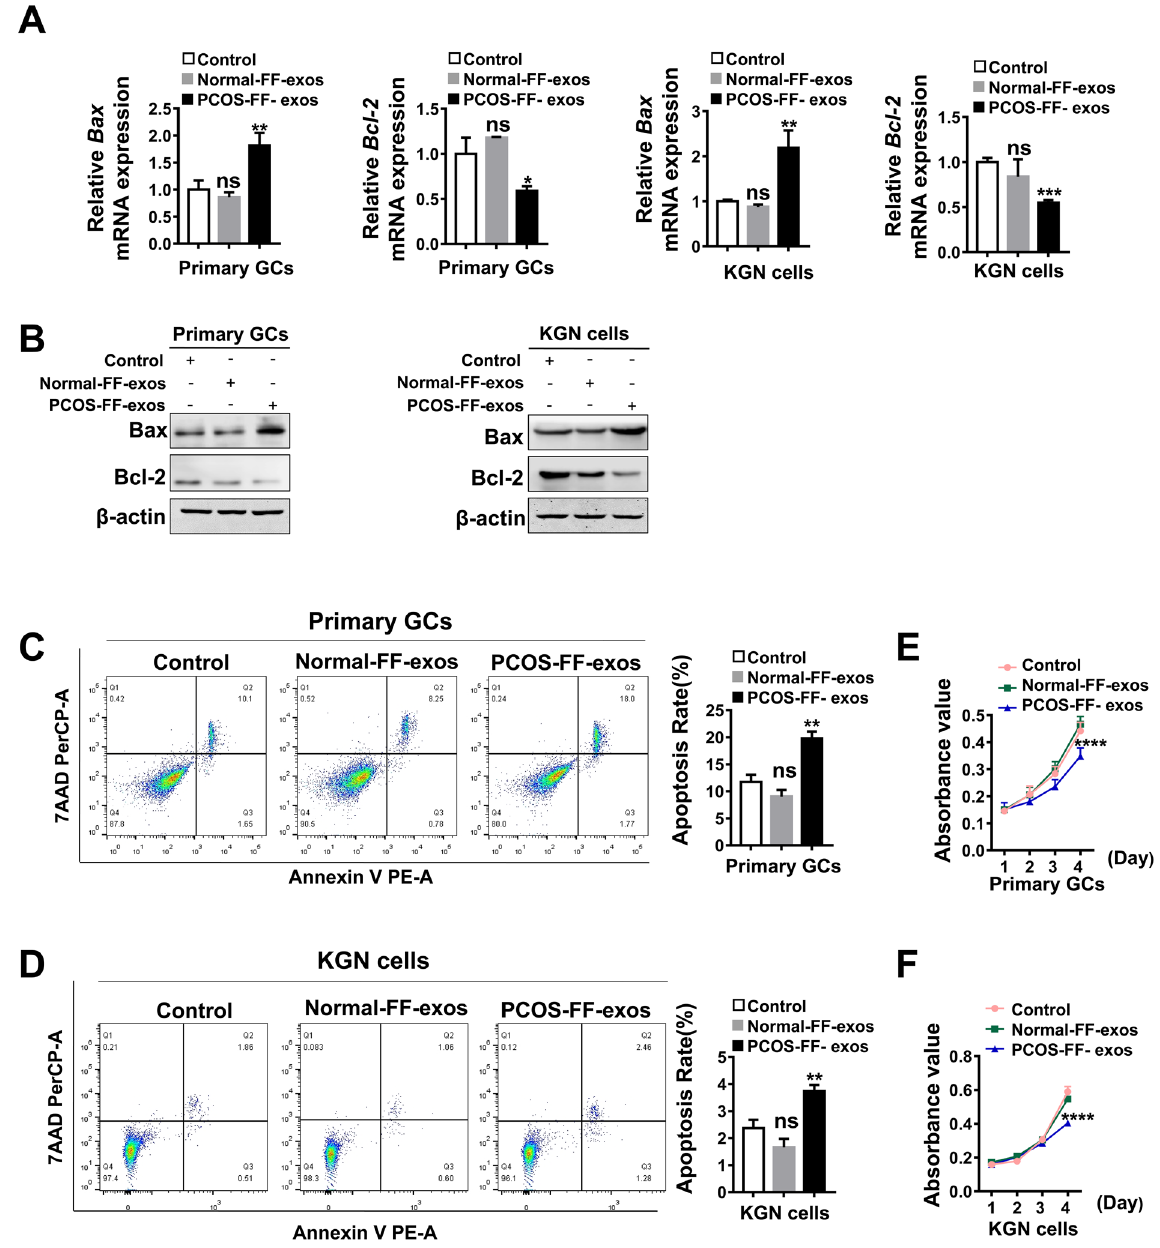
Figure 2. PCOS-FF exosomes accelerate granulosa cell apoptosis and reduce cell proliferation compared with normal-FF exosomes. (A) Quantitative PCR analysis of the expression levels of apoptosis-related genes in primary granulosa cells and KGN cell lines treated with normal-FF-exos or PCOS-FF-exos for the indicated times. (B) Western blotting analysis of the expression levels of apoptosis-related proteins in primary granulosa cells and KGN cell lines treated with normal-FF-exos or PCOS-FF-exos for the indicated times. Original blots/gels are presented in Supplementary Fig. S4. (C,D) Flow cytometry detection of apoptosis after primary granulosa cells and KGN cells were incubated with normal-FF-exos or PCOS-FF-exos for 48 h. (E,F) CCK8 analysis of cell viability after primary granulosa cells and KGN cell incubation with normal-FF-exos or PCOS- FF-exos for 3 days. All data are presented as the mean ± SD. Student’s t-test was used for statistical analysis. ns no significance, * P < 0.05, ** P < 0.01, *** P < 0.001, **** P < 0.0001 for comparison with primary granulosa cells and KGN cells treated with PCOS-FF- exosomes compared with PBS and normal-FF- exosomes (Fig. 3C,D). Thus, our results suggest that miR-143-3p is enriched in PCOS-FF derived exosomes. Exosomal‑miR‑143‑3p promotes granulosa cell apoptosis and suppresses proliferation in vitro. To further clarify the biological roles of miR-143-3p in granulosa cell apoptosis and proliferation, miR-143-3p mimic or inhibitor were transfected into KGN cells. As expected, miR-143-3p mimic significantly